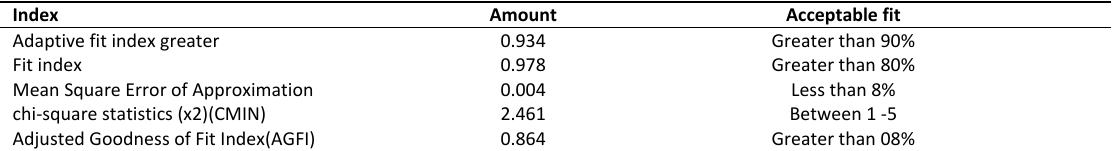
Table 6: Results of structural equation modeling test to fit the research conceptual